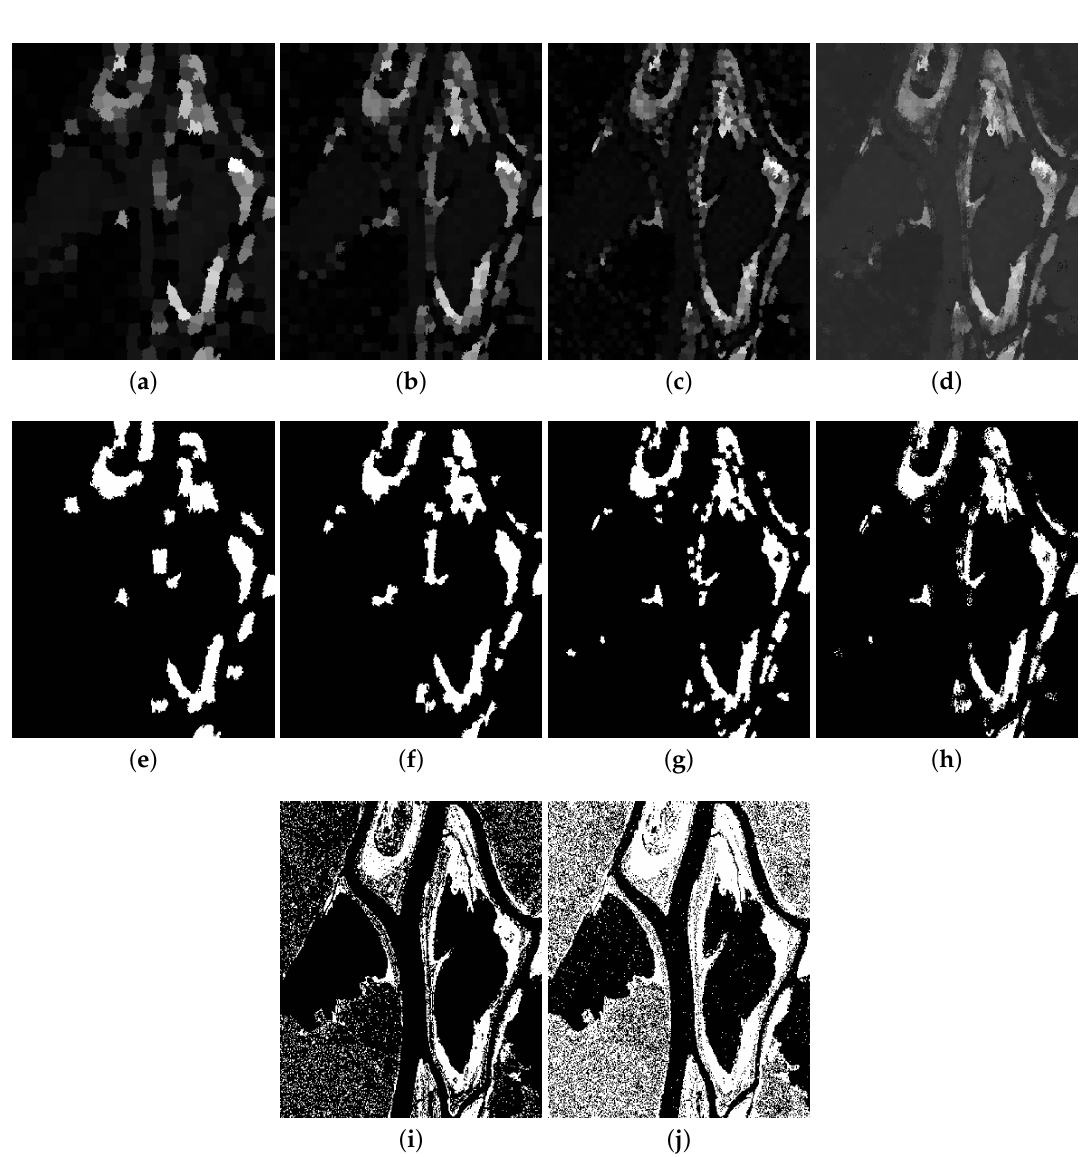
Figure 5. Results of saliency detecion and change detection for Ottawa dataset. ( a – c ): Saliency map at scale 500, 1000, 2000, respectively. ( d ) Fused saliency map. ( e – h ): Change maps by K-means on ( a – d ), respectively. ( i ): Change map by K-means directly on DI. ( j ): Change map by